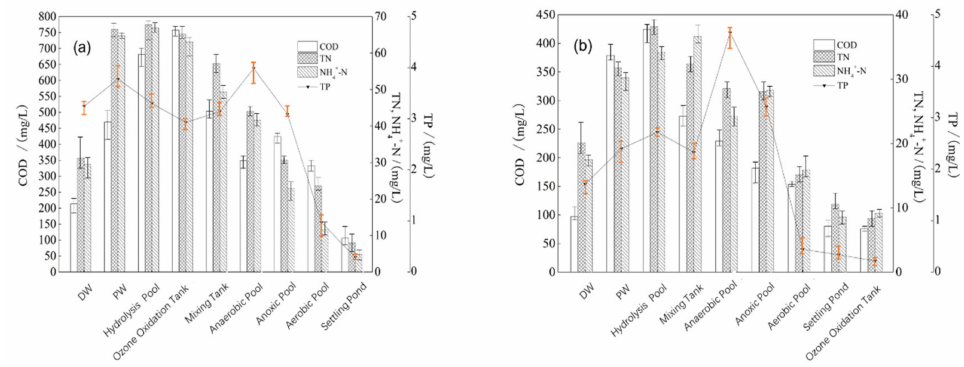
Figure 5. The variation of the COD, NH 4 + -N, TP and TN concentrations for ( a ) pre-ozone and ( b ) post-ozone treatment (50% PW). (Each data is from three parallel